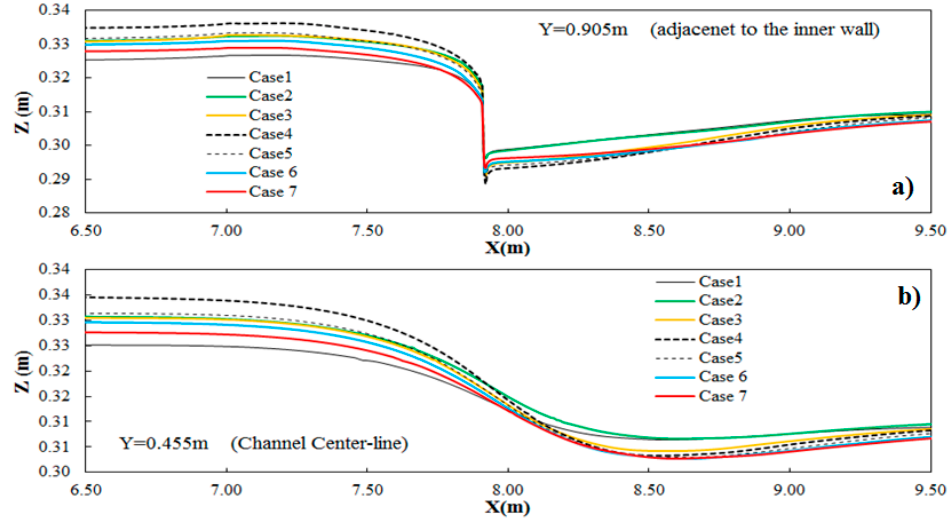
Figure 7. Longitudinal flow surface profiles at ( a ) Y = 0.905m and ( b ) Y = 0.455m (channel centerline).